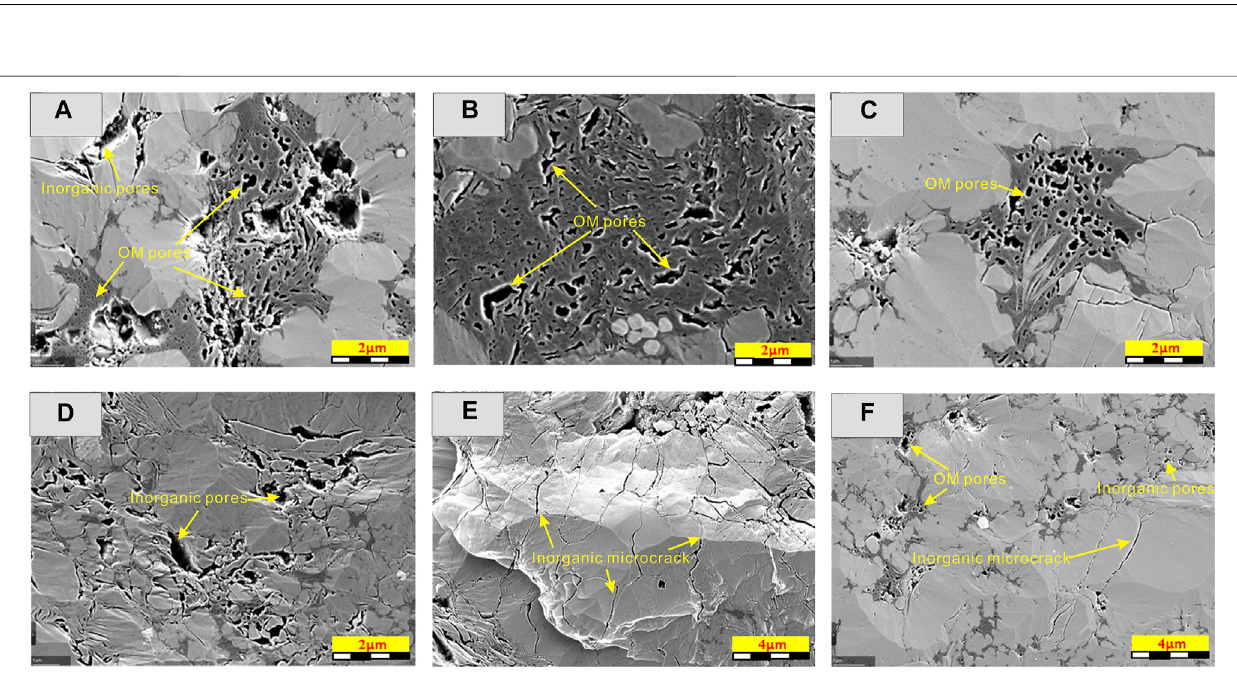
Frontiers in Earth Science |